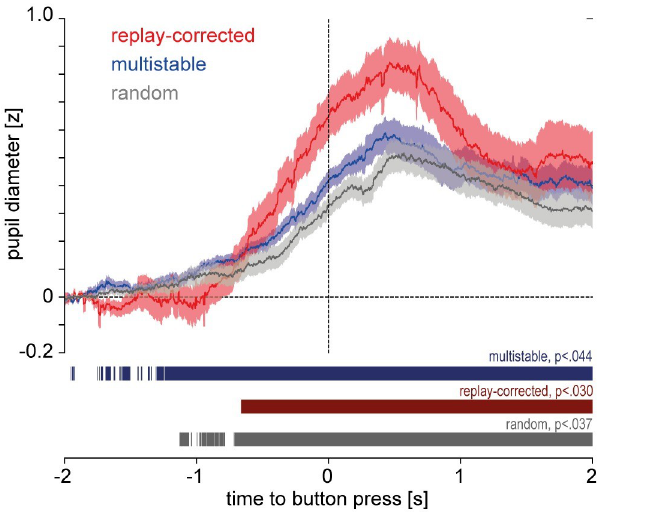
Fig 7. Pupil traces, Study 2. Pupil diameter between 2 s before and 2 s after the button press, z-normalized and subtractively baseline-corrected to 0 mean between [-2 s and -1.8 s]; solid lines: mean, shaded areas: standard error of mean (sem). Colored segments denote periods in which pupil size is significantly different from 0 at an expected FDR of 0.05; adjusted alpha level is denoted on top of the segment.